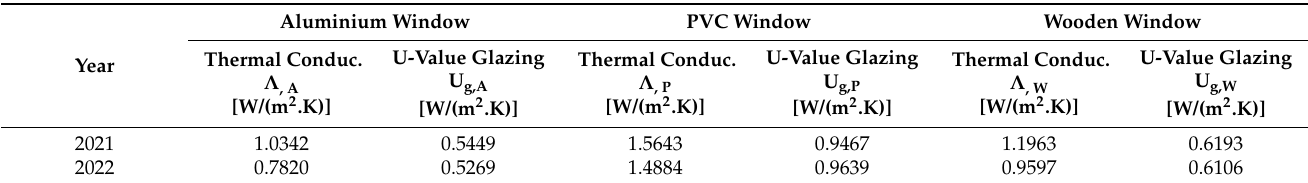
Table 3. Data measured in the pavilion laboratory.